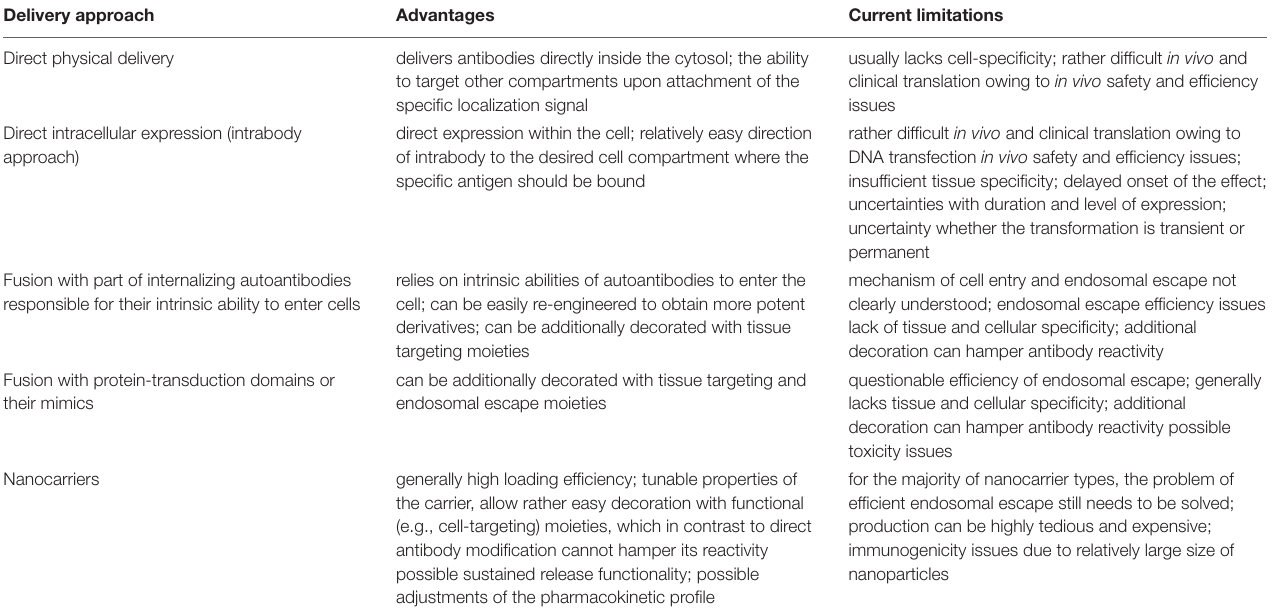
TABLE 5 | Advantages and limitations of different approaches used for the intracellular delivery of